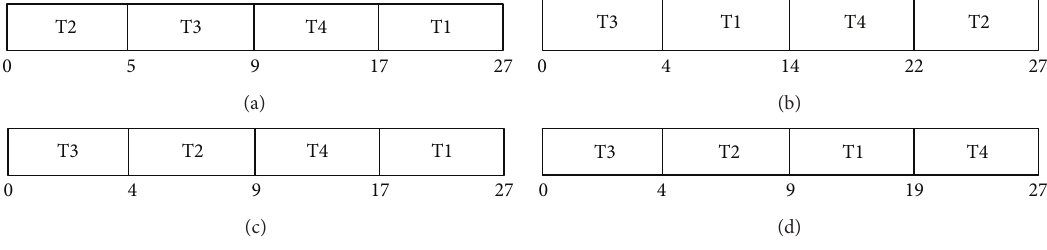
Figure 7: (a) Gantt chart for VOPS. (b) Gantt chart for PS. (c) Gantt chart for SJF. (d) Gantt chart for